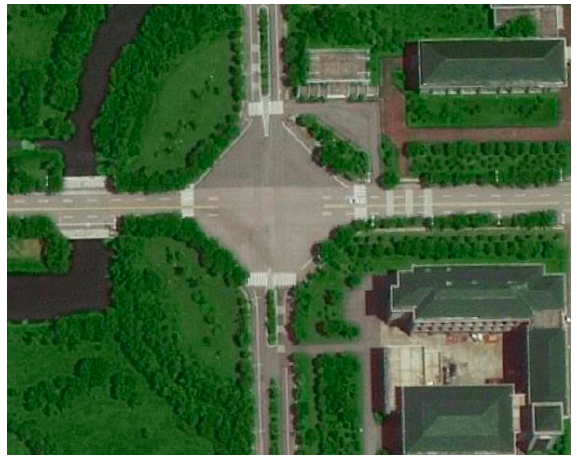
Figure 5. Bird’s-eye view of the intersection in ground test.